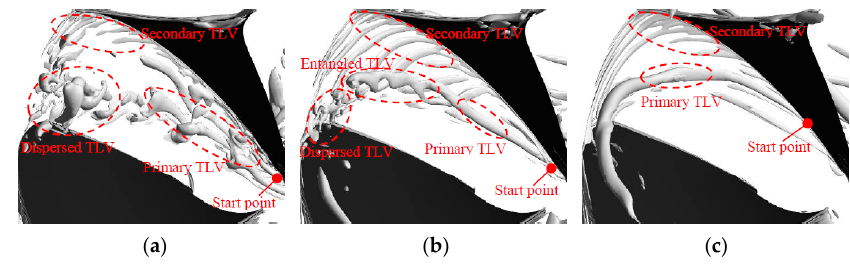
Figure 18. Distribution of swirling strength and separation angels on different circumferential sections for different tip clearances: ( a ) 0.2 mm; ( b ) 0.65 mm; ( c ) 1.0 mm [5].